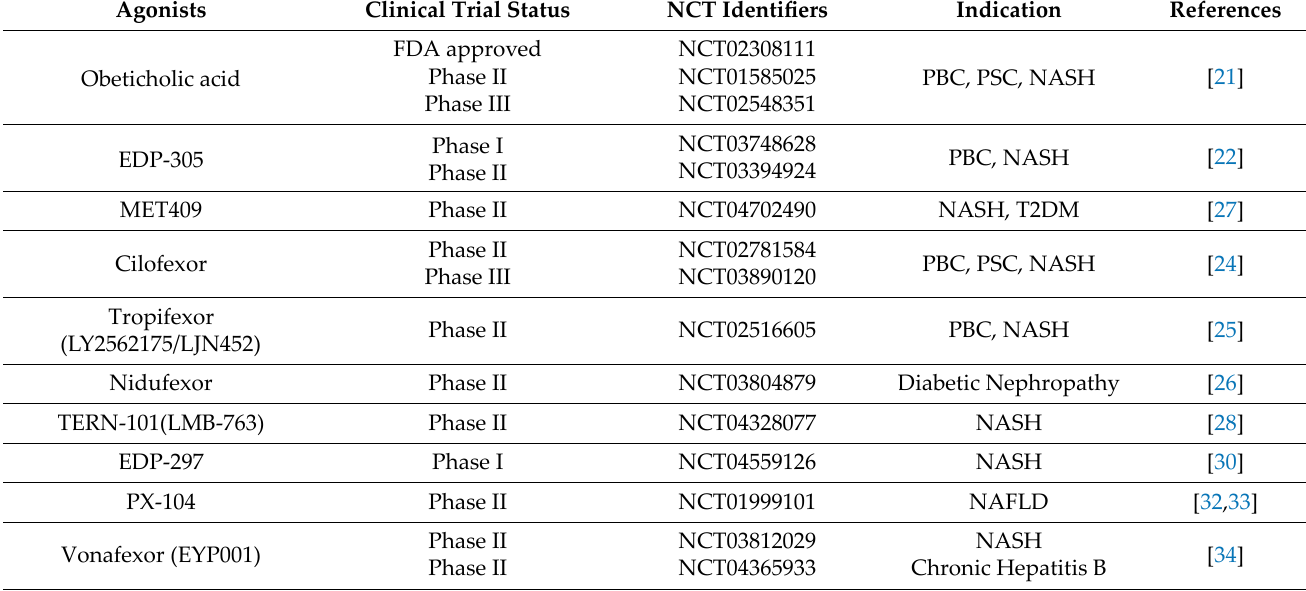
Table 2. FXR agonist clinical